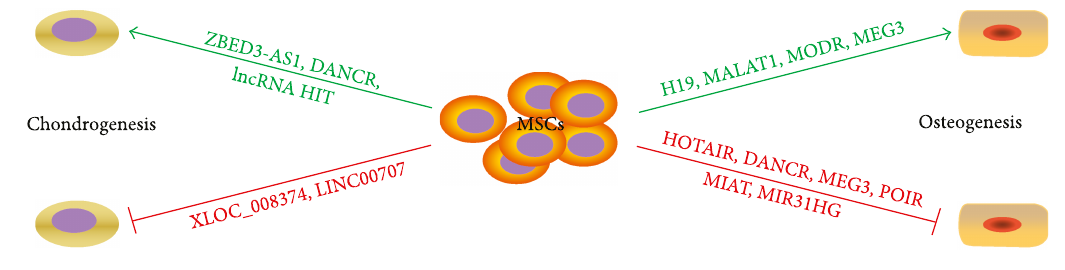
Figure 1: lncRNAs that promote osteogenic di ff erentiation of stem